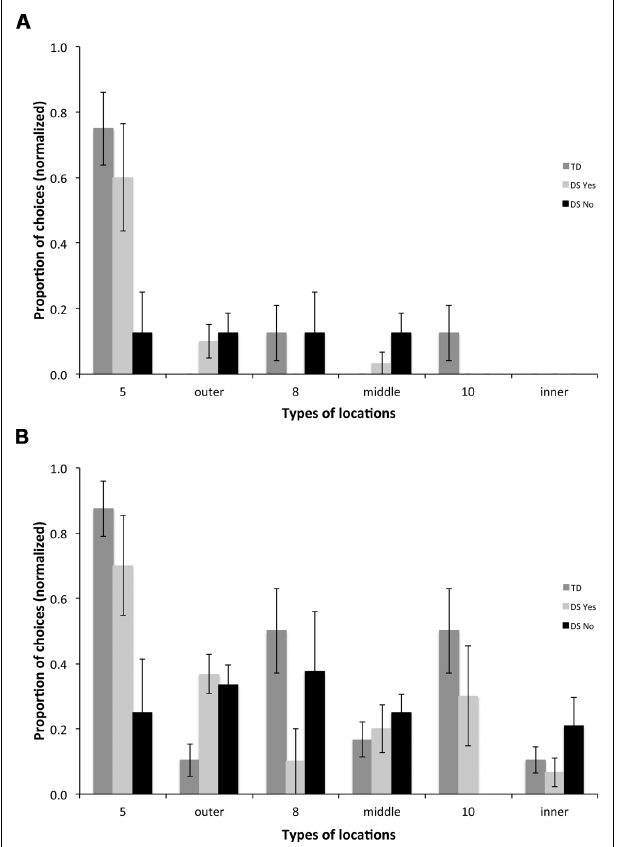
FIGURE 8 | Types of locations visited for the first (A) and the first three (B) choices upon entering the arena in the probe trial, the first trial of Day 2 performed in theAS condition. 5: rewarded location on the outer array; outer: non-rewarded locations on the outer array; 8: rewarded location on the middle array; middle: non-rewarded locations on the middle array; 10: rewarded location on the inner array; inner: non-rewarded locations on the inner